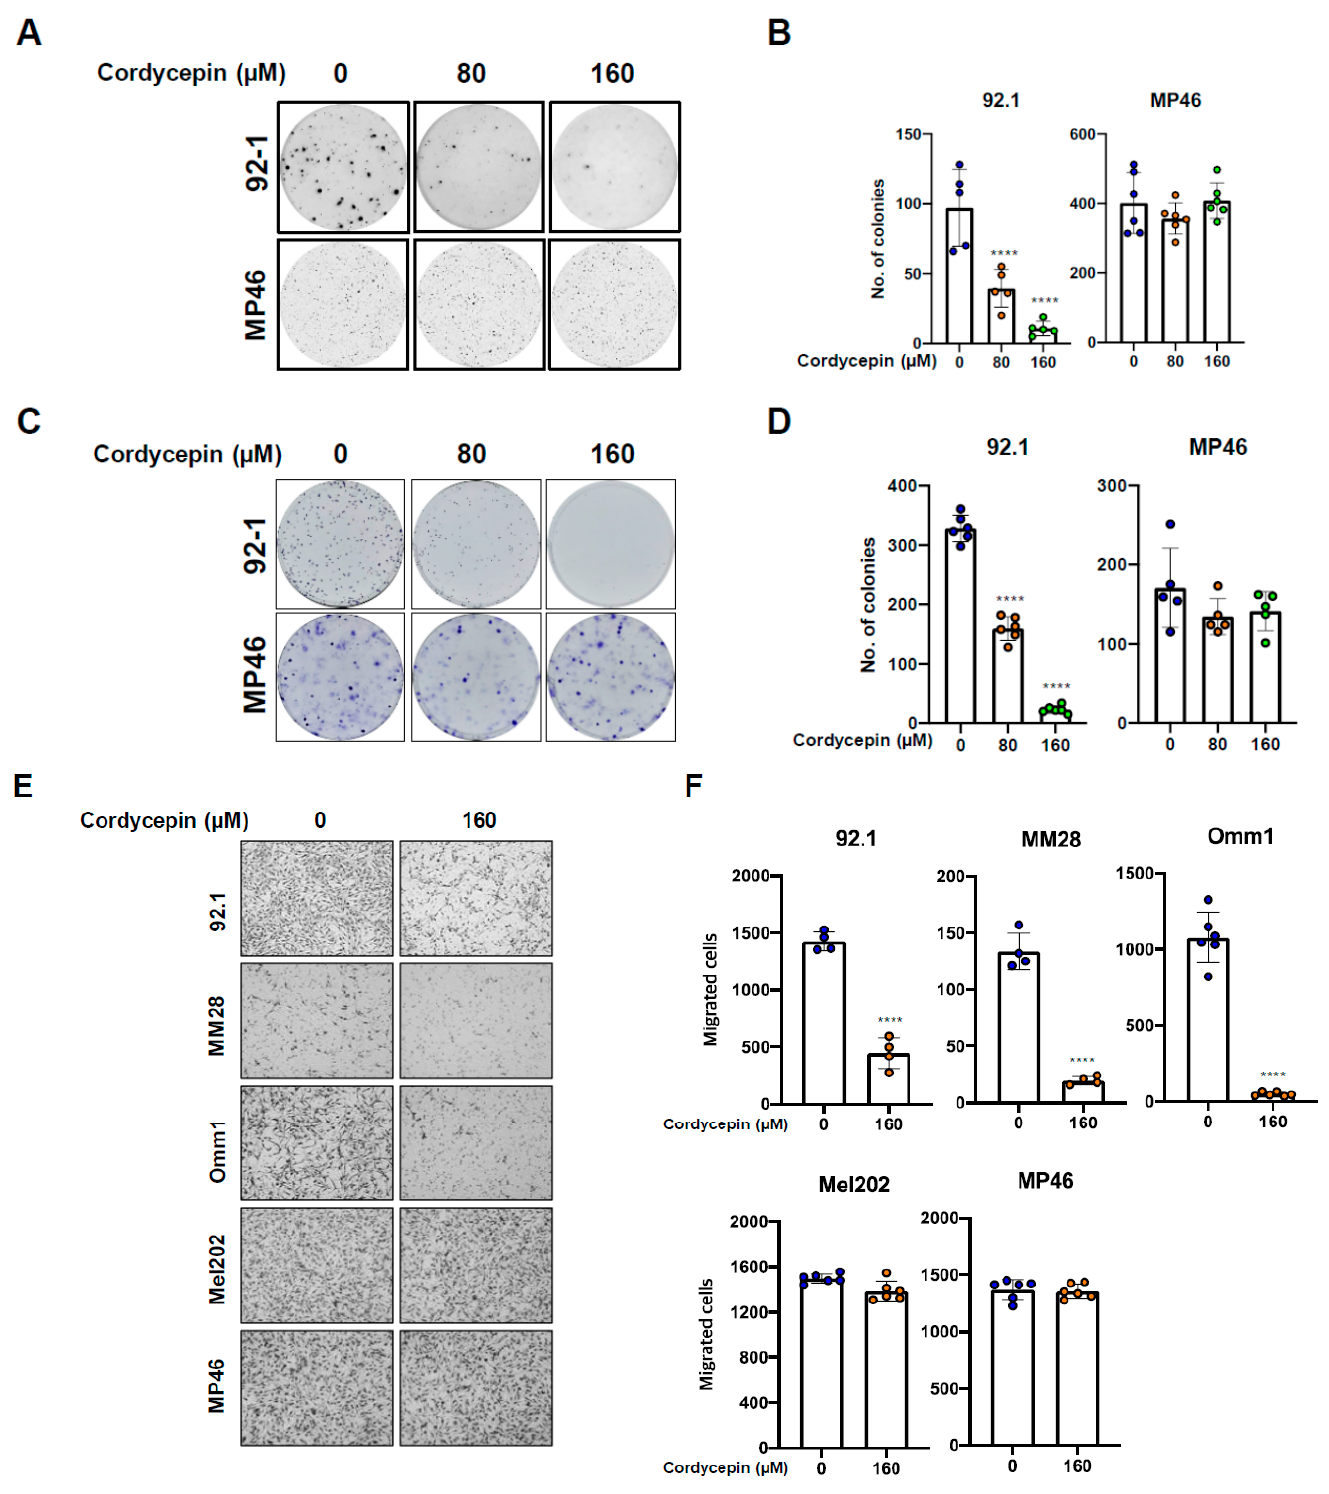
Supplementary Figure S1D,E).